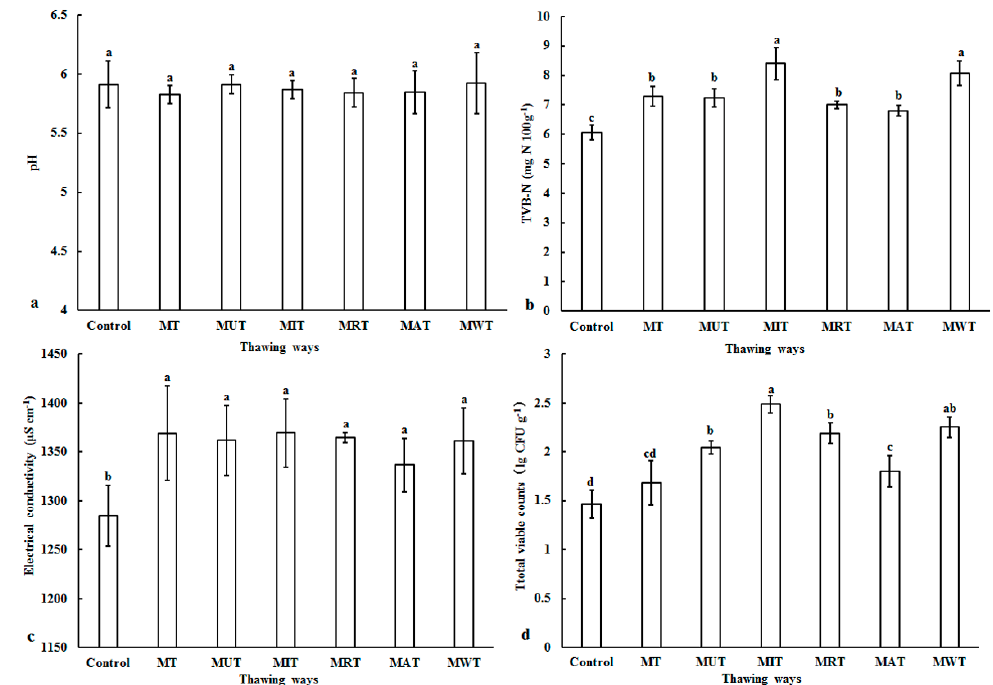
Figure 3. Changes in pH ( a ), total volatile base nitrogen (TVB-N , ( b )), electrical conductivity, ( c ) and total viable counts ( d ) of pork samples under six different thawing conditions. MT: Microwave thawing (100 W); MUT: Microwave combined with ultrasonic thawing; MIT: Microwave combined with 35 °C water immersion thawing; MRT: Microwave combined with 4 °C refrigeration thawing; MAT: Microwave combined with air convection thawing; MWT: Microwave combined with running water thawing. a–d values in the same series followed by different letters are significantly different according to Duncan’s multiple range test ( p < 0.05).